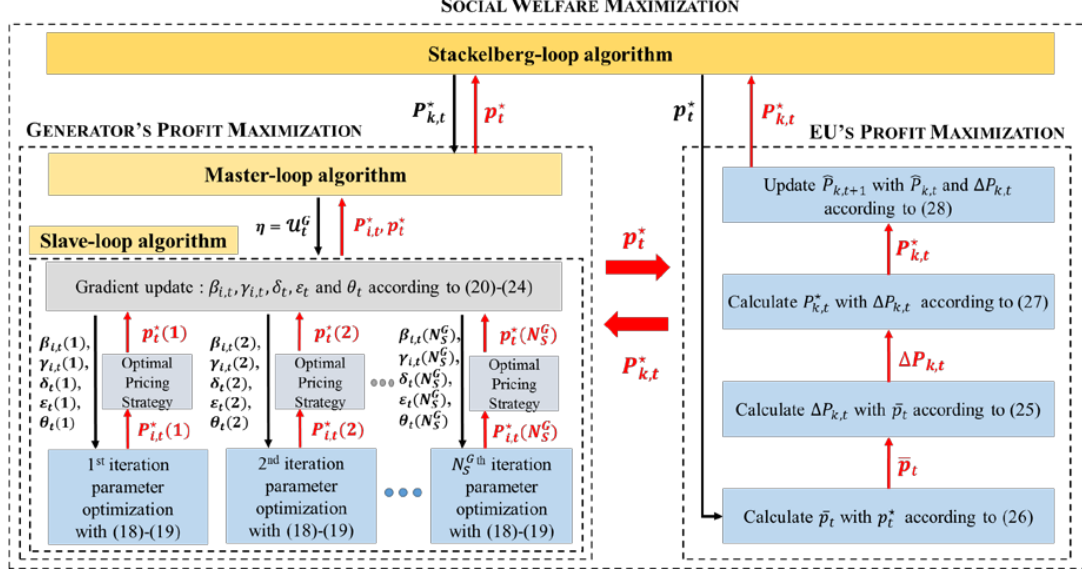
Figure 2 . The diagram of the proposed iterative algorithm for social welfare maximization in smart grid.